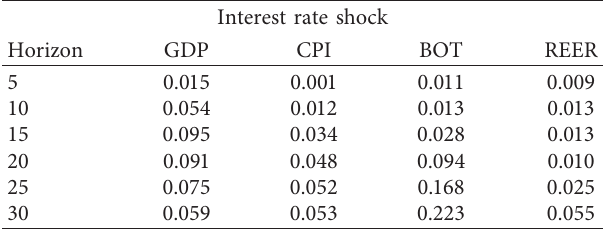
Fed asset shock